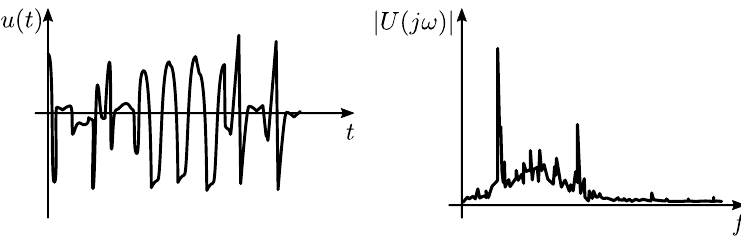
Figure 5. Ferroresonance characteristics for chaotic